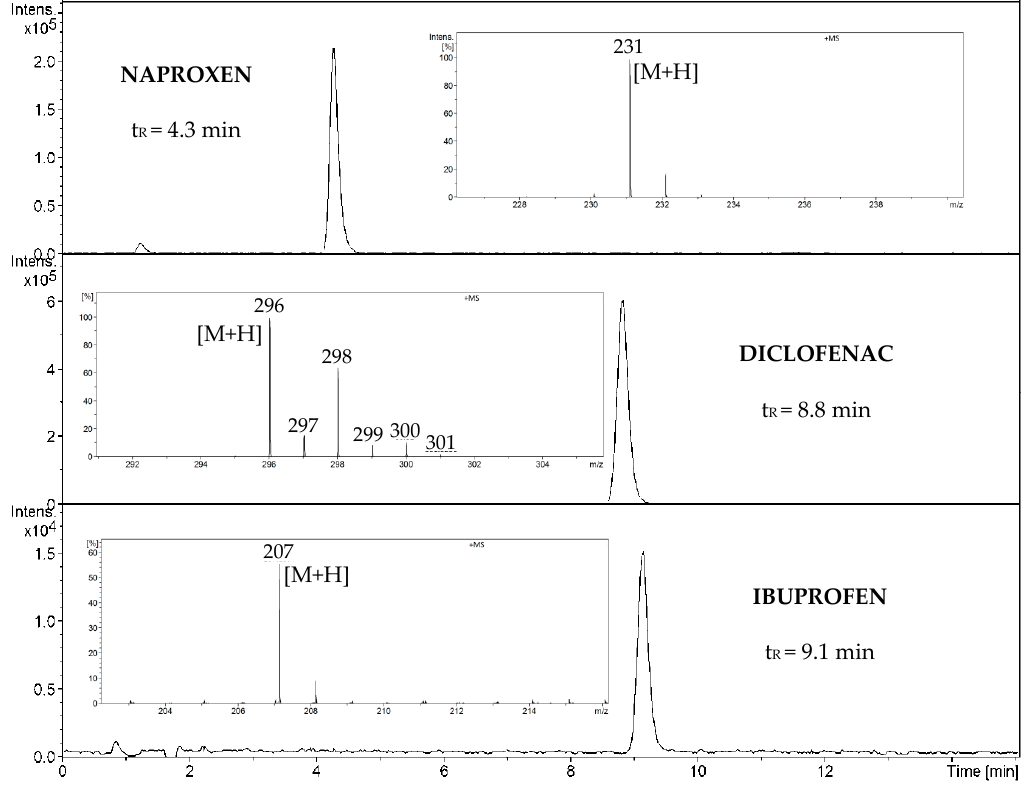
Figure 4. Extracted ion chromatogram (EIC) HPLC-MS spectra of naproxen, diclofenac, and ibuprofen.